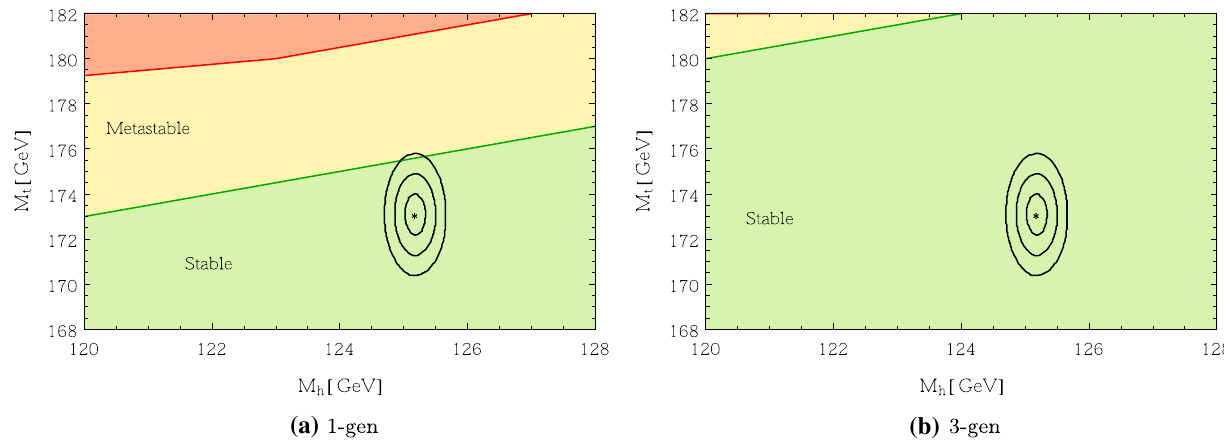
Fig. 13 Phase space diagram with Higgs mass M h vs top mass M t in GeV for (cid:2) R 2 . Green, yellow and red colours correspond to stable, metastable and unstable regions, respectively. The black dotted circles denote 1 σ , 2 σ and 3 σ contours, and the black dot denotes the current Higgs mass and top mass value